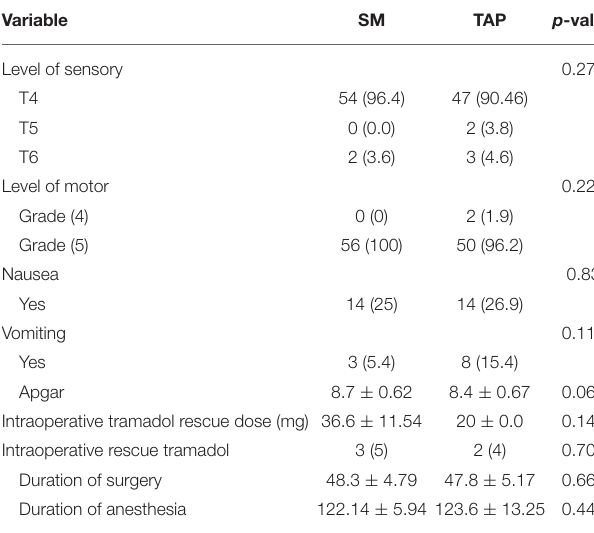
TABLE 2 | Comparison of perioperative factors in elective caesarian delivery under spinal anesthesia and randomized to either SM or a TAP block for postoperative pain